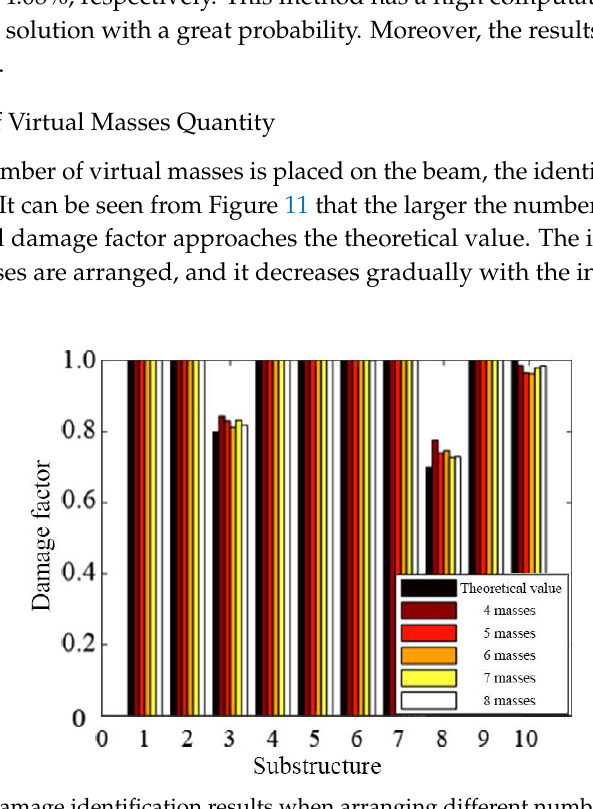
Figure 11. Damage identification results when arranging different numbers of masses.